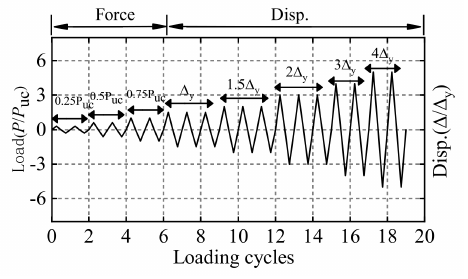
Figure 4. Loading